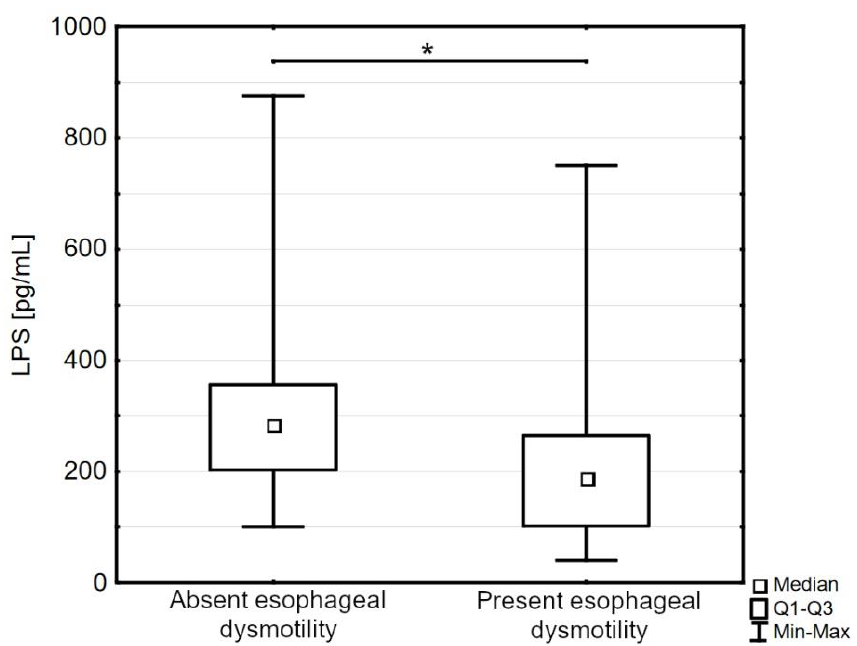
Figure 3. The serum concentration of lipopolysaccharides (LPS) in the patients with systemic sclerosis and absent esophageal dysmotility compared to the subgroup with present esophageal dysmotility; Q1—the first quartile; Q3—the third quartile; Min—the lowest value; Max—the highest value (* p < 0.05).